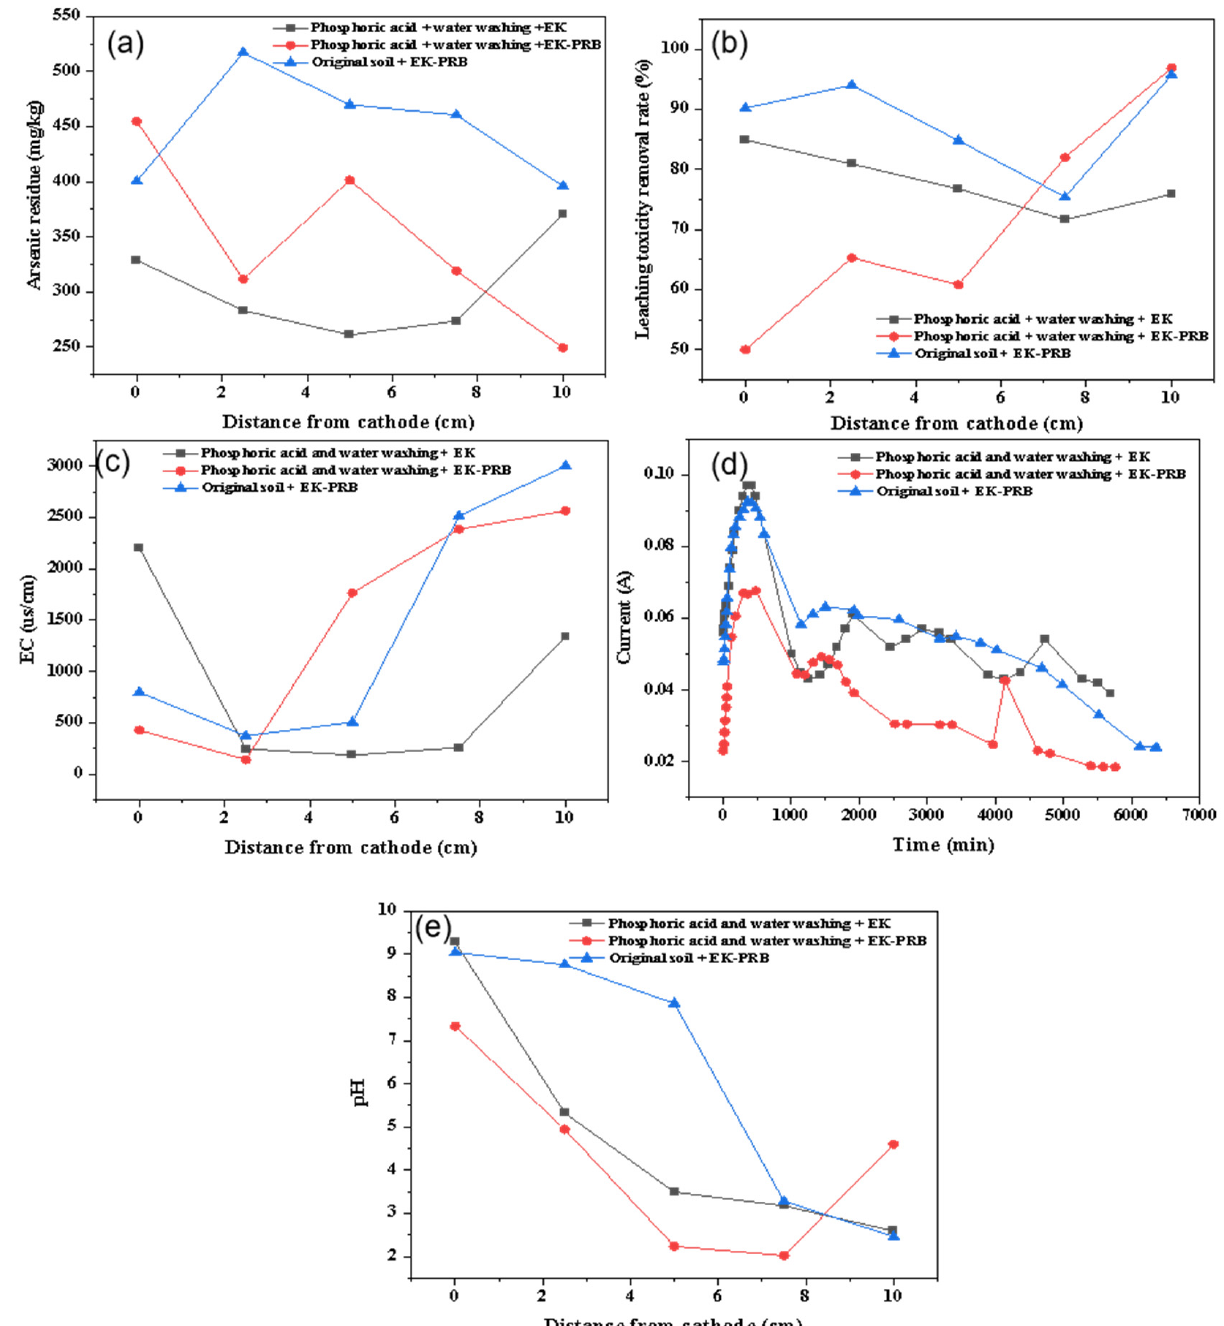
Figure 3. Effect of phosphoric acid and water washing on EK-PRB remediation of arsenic- contaminated soil. Arsenic residue ( a ), leaching toxicity removal rate ( b ), EC ( c ), current ( d ) and pH ( e ).